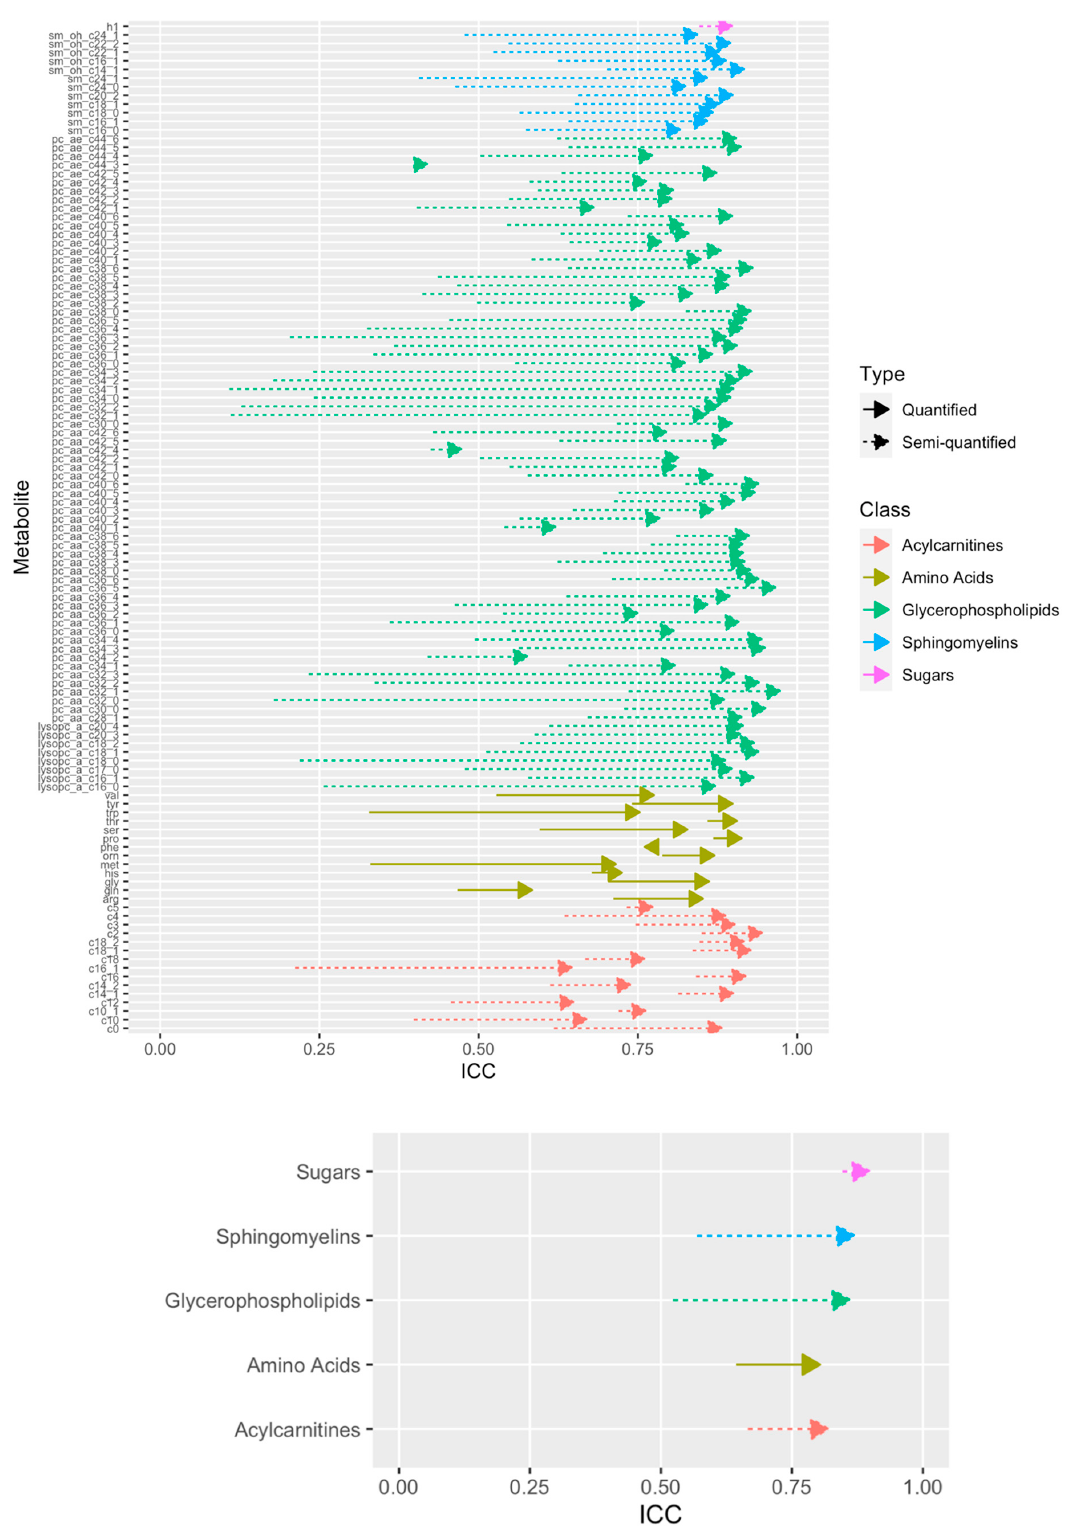
Figure 5. Metabolite-specific ICC values before and after normalization ( top ) and average ICC values for each class of metabolites before and after normalization ( bottom ). For each arrow, its origin represents the ICC value before normalization, and its peak represents the ICC value after normalization. In each plot, the x − axis represents the ICC value, and the y − axis each particular metabolite ( top ) or class of metabolites ( bottom ).